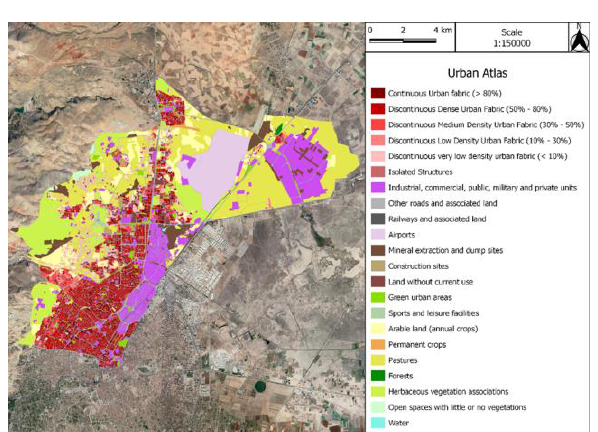
Figure 3. Land use Urban Atlas Map 2012